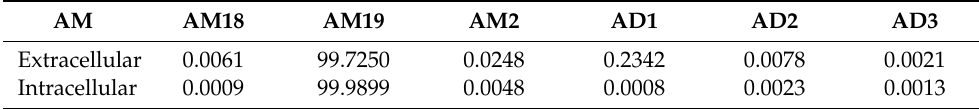
Table 2. Proportion of different AMs between intracellular and extracellular